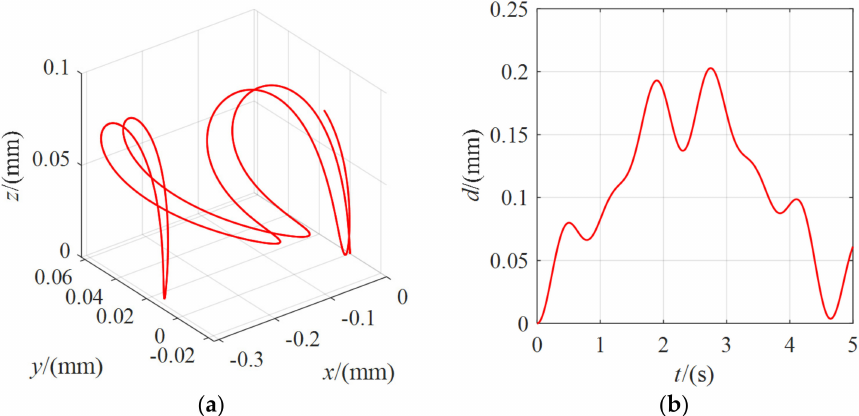
Figure 12. The position change of the moving platform under the external force of 0 N for λ = 80: ( a ) The coordinate curve of the moving platform center point in the spatial coordinate system O-xyz ; ( b ) the variation curve of the linear distance between the center point of the moving platform and the initial